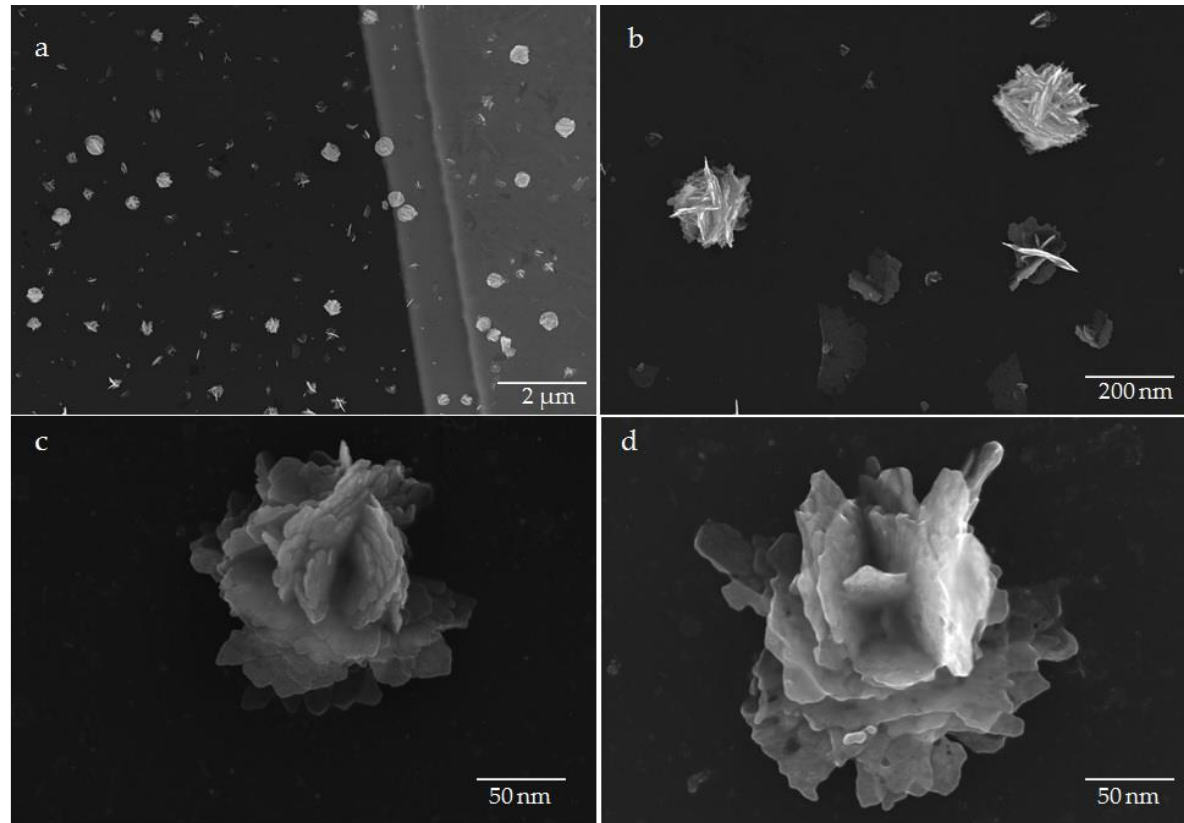
Figure 6. SEM images of flower shaped Ag-SiO 2 nanohybrid synthesized by G. flavovirens in variable magnifications ( a – d ).